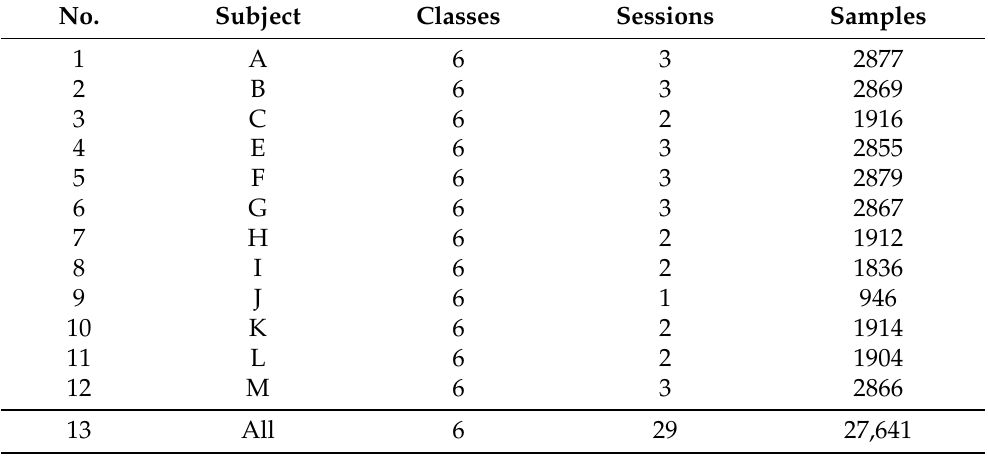
Table 2. Summary of BCI interaction paradigm data related to six mental imagery tasks, as presented in